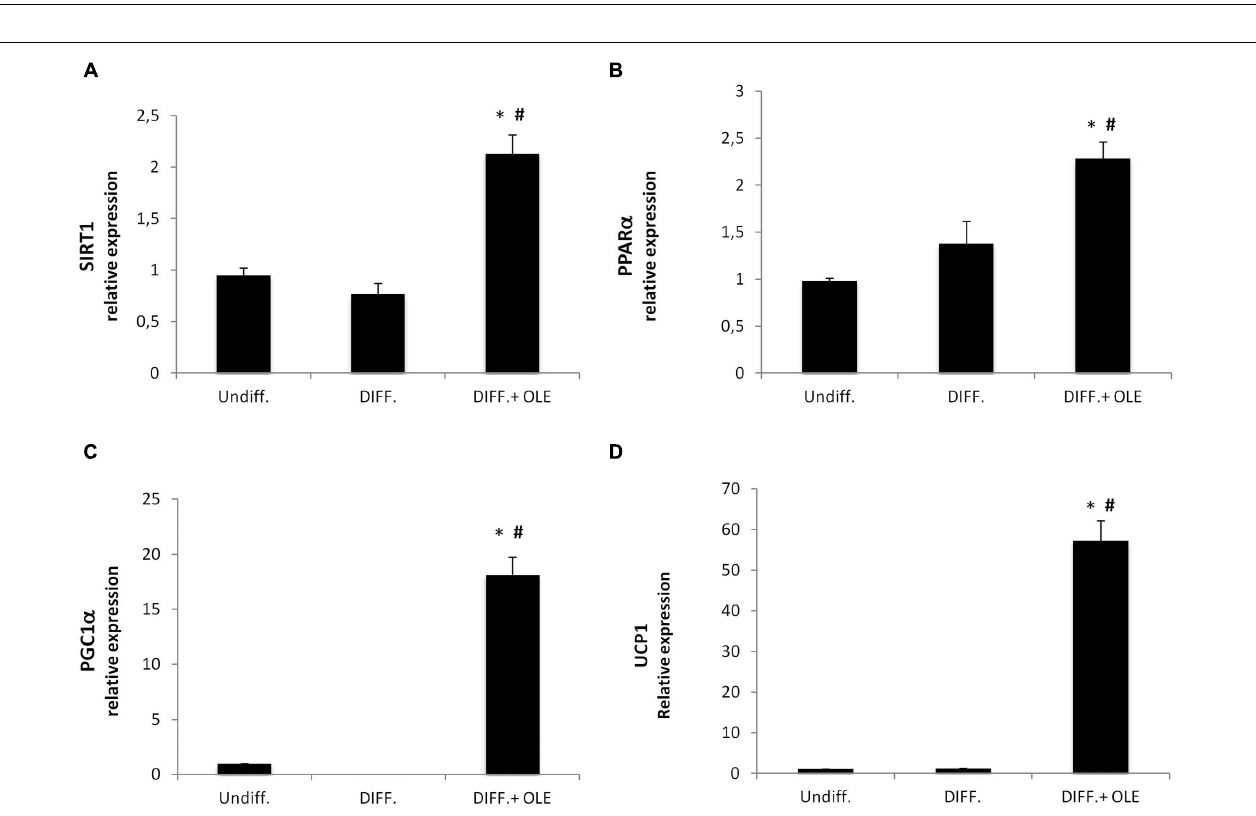
FIGURE 5 | Analysis of gene expression by Real time PCR of thermogenic pathway. SIRT1 (A) , PPAR α (B) , PGC1 α (C) , and UCP1 (D) . ( ∗ P < 0.05 versus undifferentiated; # P < 0.05 versus differentiated).